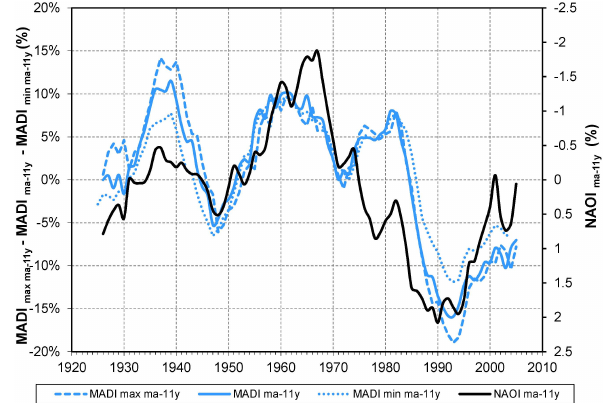
Fig. 7. Comparison between the 11-yr moving averages of the NAOI time series and the MADI max , MADI and MADI min time series of the Sanit`a spring.